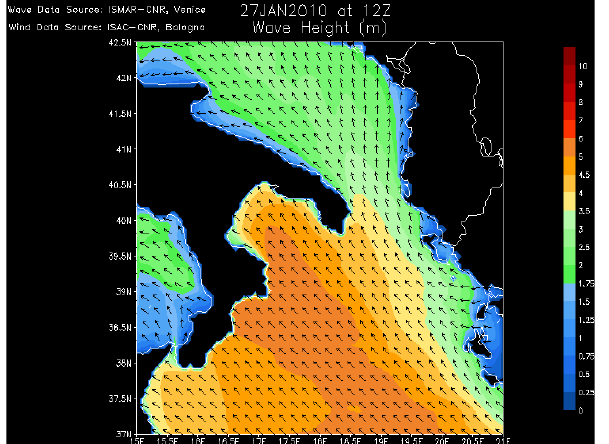
Fig. 5. An example of the WAM wave height model output for the Ionian